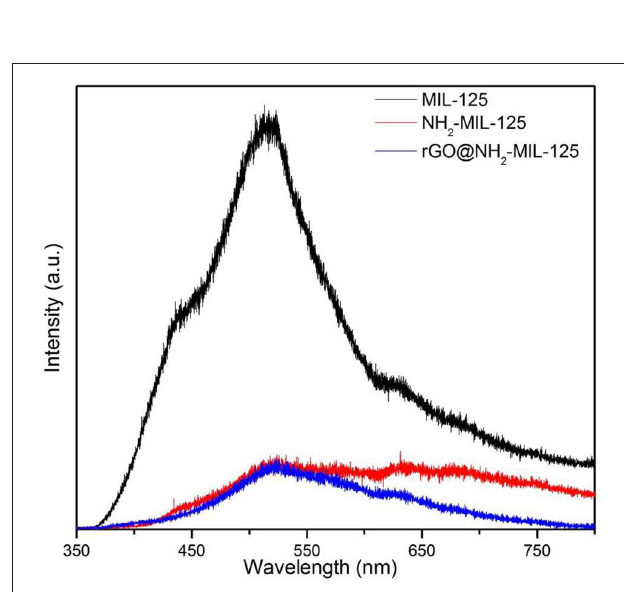
FIGURE 6 | PL spectra measured at room temperature for the three as-prepared